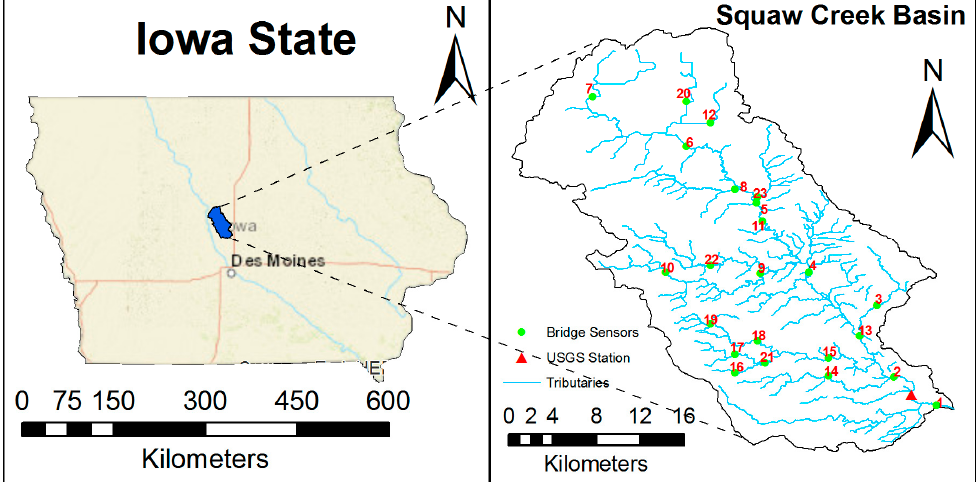
Figure 1. Squaw Creek watershed (Iowa State).